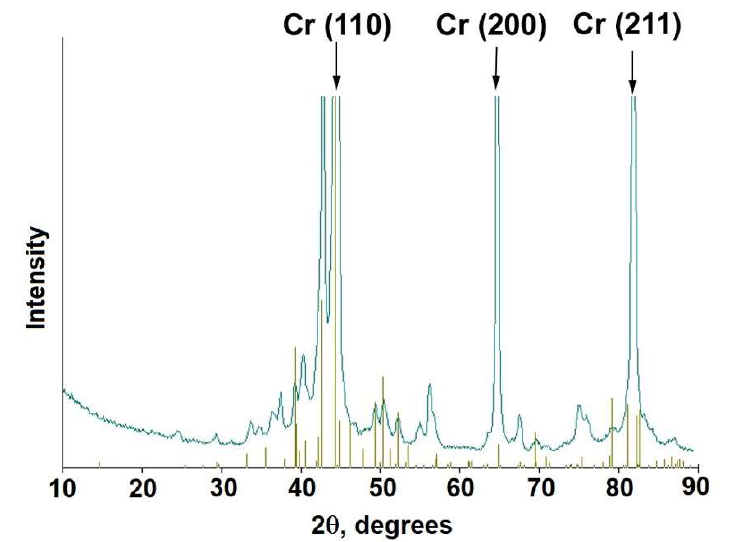
Figure 5. X-ray diffraction patterns from the composite “Cr+15% ND” after annealing at 690 °C. Arrows: chromium; vertical lines: chromium carbide (Cr 7 C 3 ) .